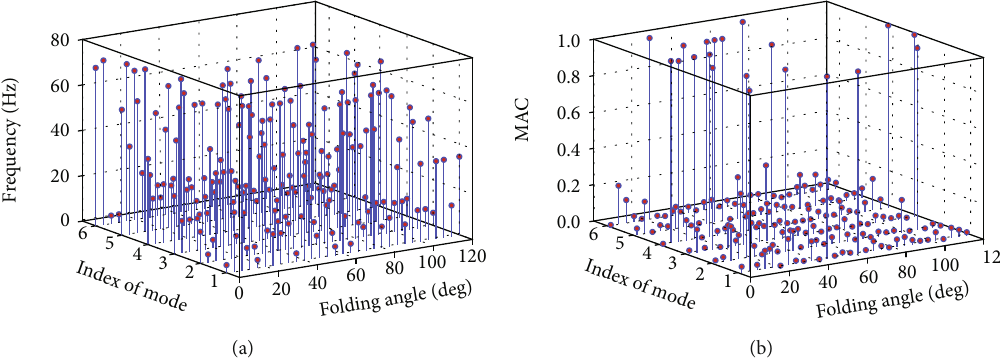
Figure 4: The scrambled structural modes (a) and the MAC between every two adjacent folding angles (b).